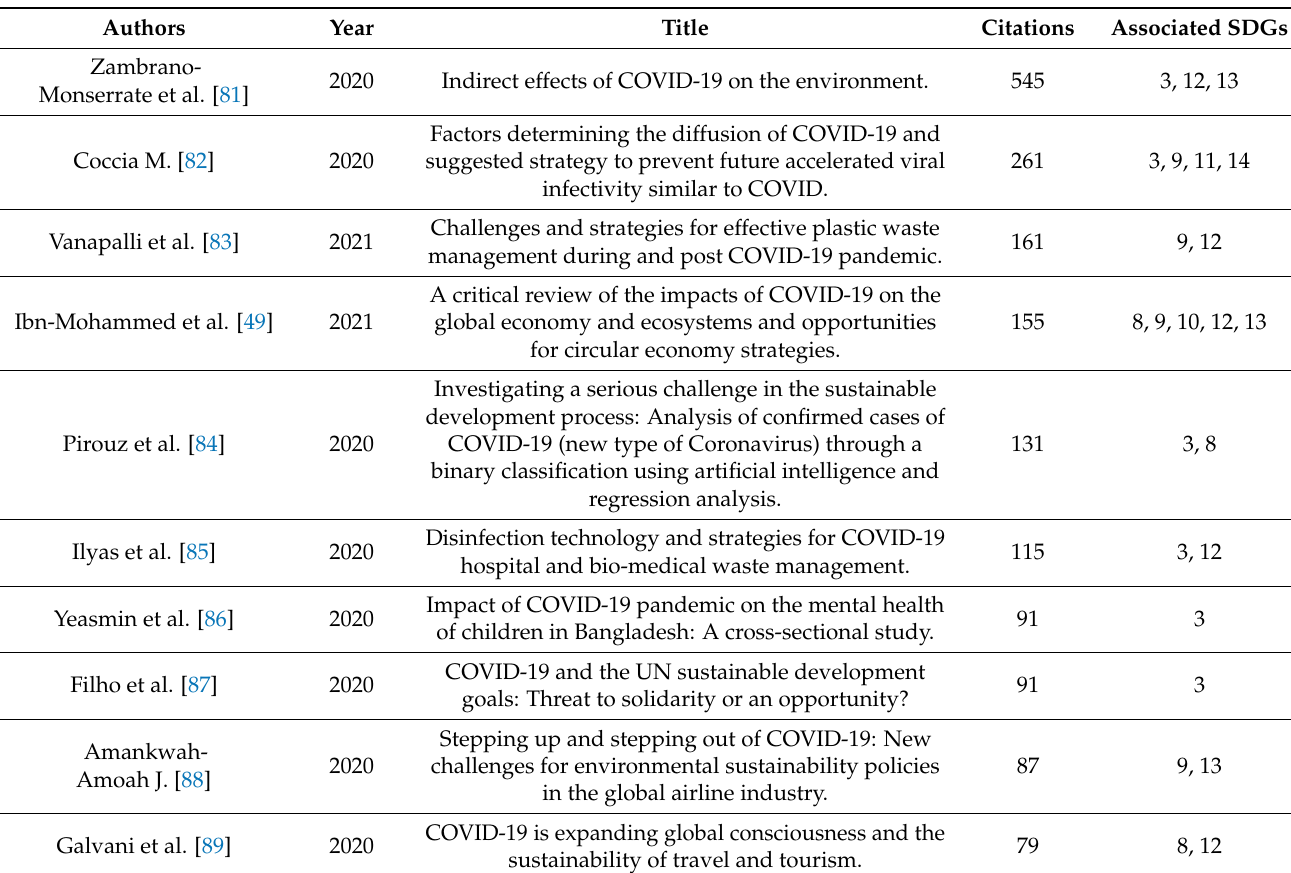
Table 3. The 10 most cited